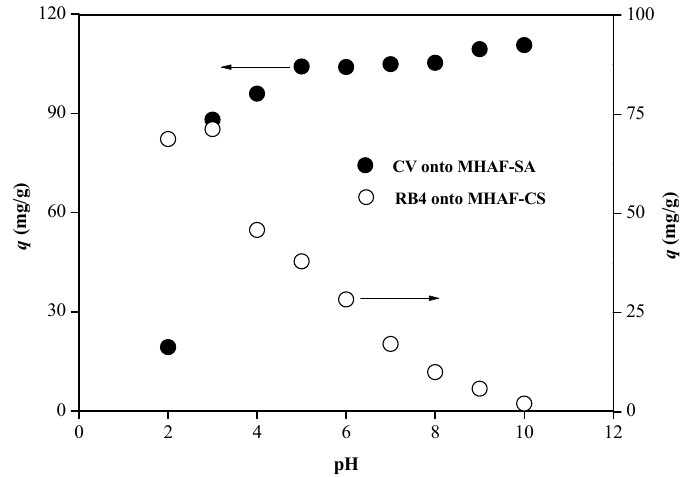
Figure 5. Effect of pH on dye adsorption.